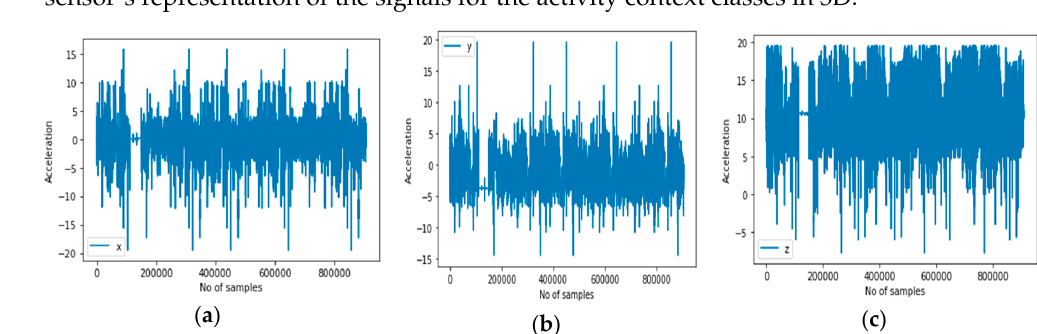
Figure 4. 3-D accelerometer signals representing all activity contexts. ( a ), ( b ), and ( c ) respectively are the x, y, and z axes of the accelerometer sensor.